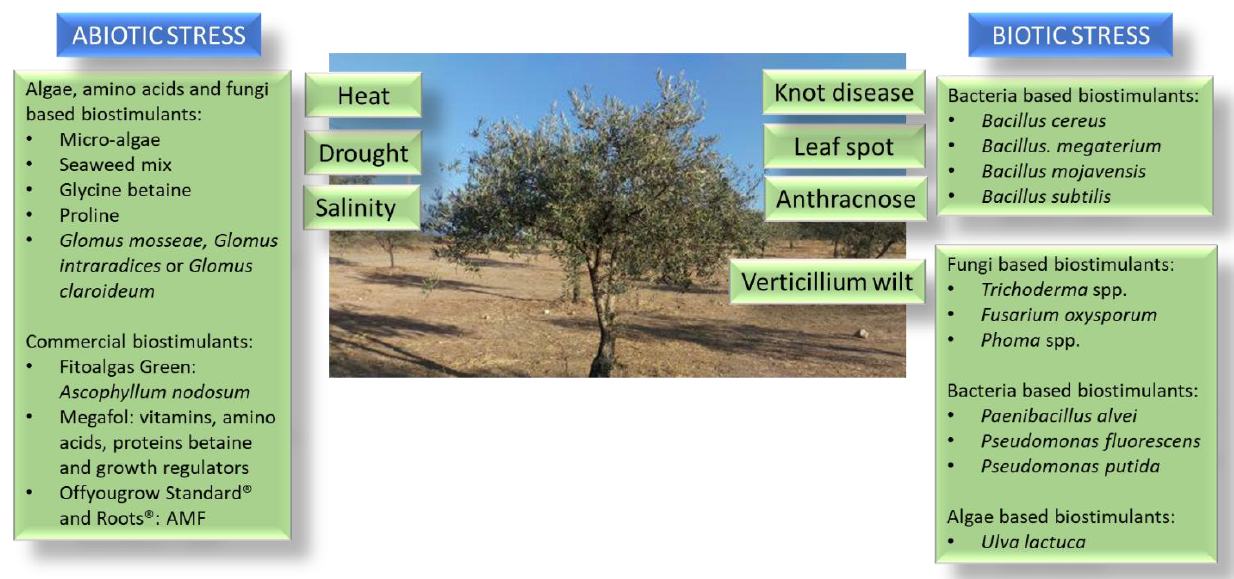
Figure 1. Biostimulants used to control abiotic and biotic negative effects on olive tree .